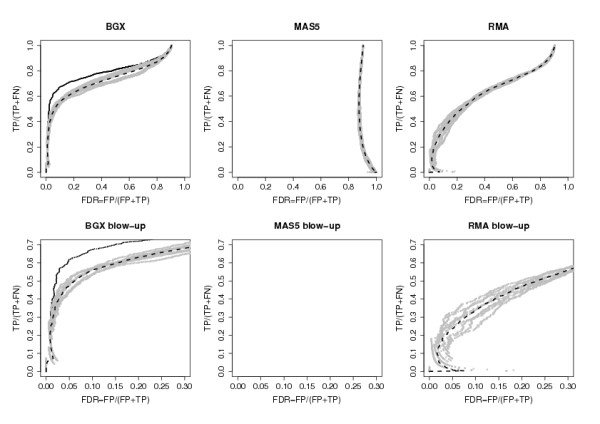
ROC curves for one versus one comparisons of arrays from the Choe data set obtained with different methods. A curve is plotted for each pairwise comparison of a single C array to a single S array (9 grey lines) with the average curve superimposed (broken black). For BGX the curve obtained from an analysis that uses all three C replicate arrays against all three S replicate arrays is also shown (full black line). For BGX ranking (1) is used (see text). For MAS5 and RMA genes are ranked on their absolute value of difference in expression. The lower panels are blow-ups of the leftmost parts of the upper panels. TP: true positives, FP: false positives, TN: true negatives, FN: false negatives.